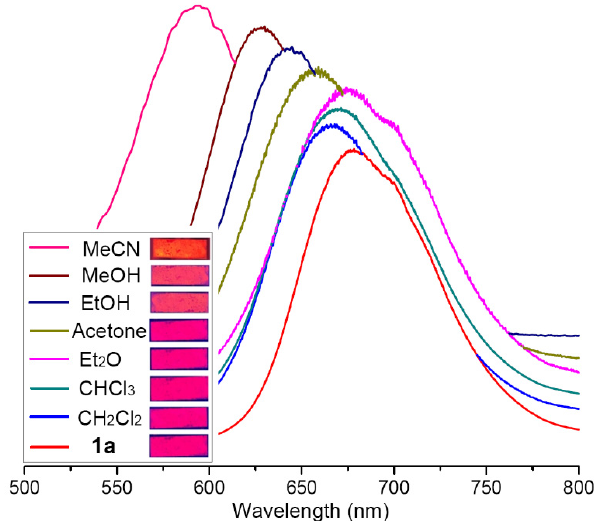
Figure 4. Emission spectra of 1a and 1a on exposure to different VOC vapors upon excitation at 400 nm. Photos of the powdered 1a and 1a (coating on a quartz slice) on exposure to different VOC vapors under 365 nm excitation (inset).